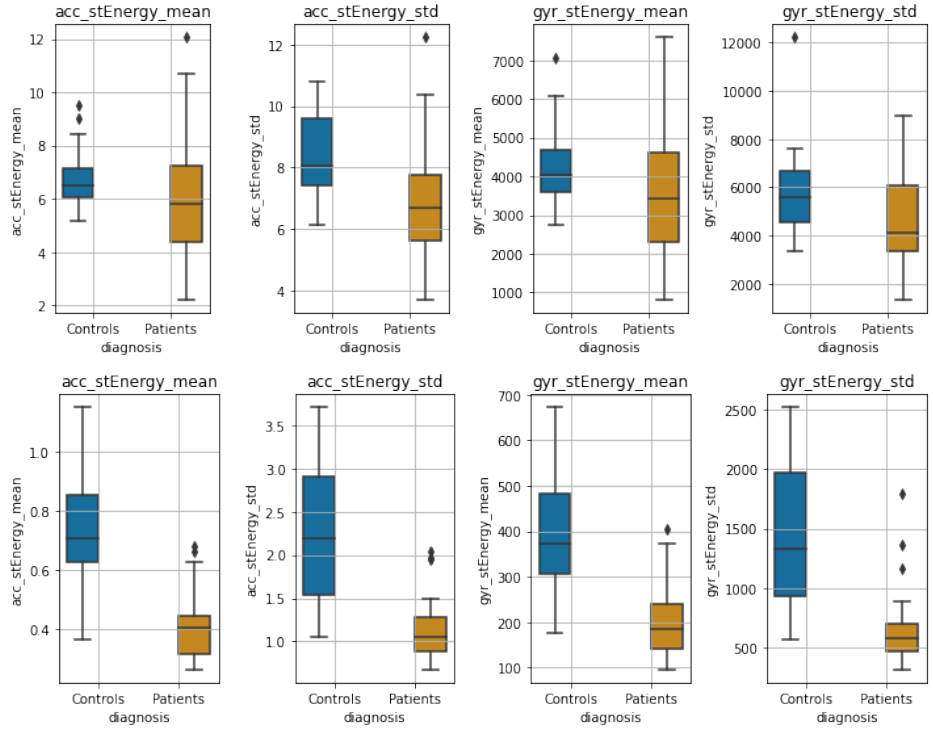
Figure 8. Boxplots for accelerometer and gyroscope features of controls (in blue) and patients (in light brown) while ( top ) awake and ( bottom ) asleep. The bold line represents the median, the boxes extend between the 1st and 3rd quartile, whiskers extend to the lowest and highest datum within 1.5 times the inter-quantile range (IQR) of the 1st and 3rd quartile, respectively, and outliers are shown as